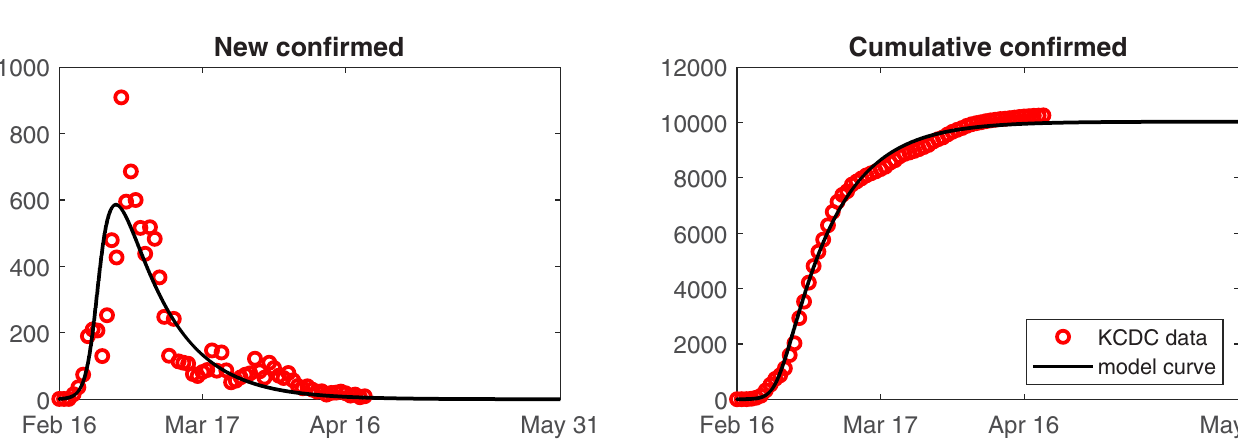
PLOS ONE | https://doi.org/10.1371/journal.pone.0238684 September 24,